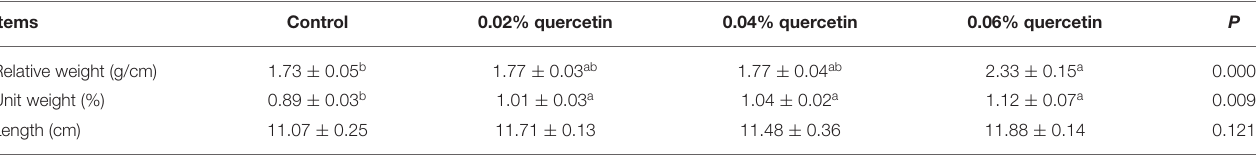
TABLE 3 | Effect of quercetin on length and weight of tibia in broilers.